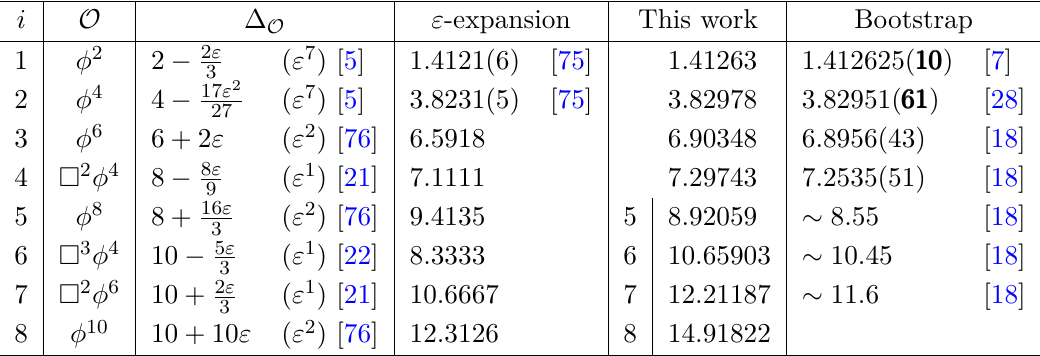
for O ( ε 2 ) result (see (4.3)), [1 , 1]